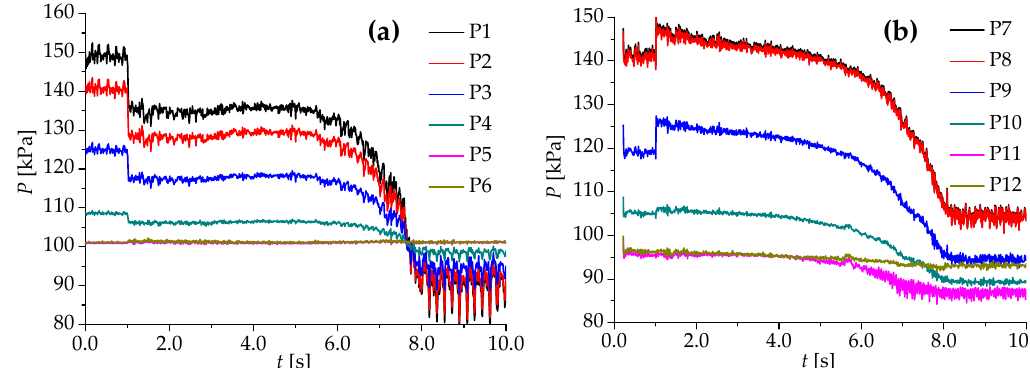
Figure 8. Numerical simulation of the pressures P for the Francis turbine under a load rejection condition. ( a ) The pressure measurement points at the USRC; and, ( b ) The pressure measurement points at the LSRC.